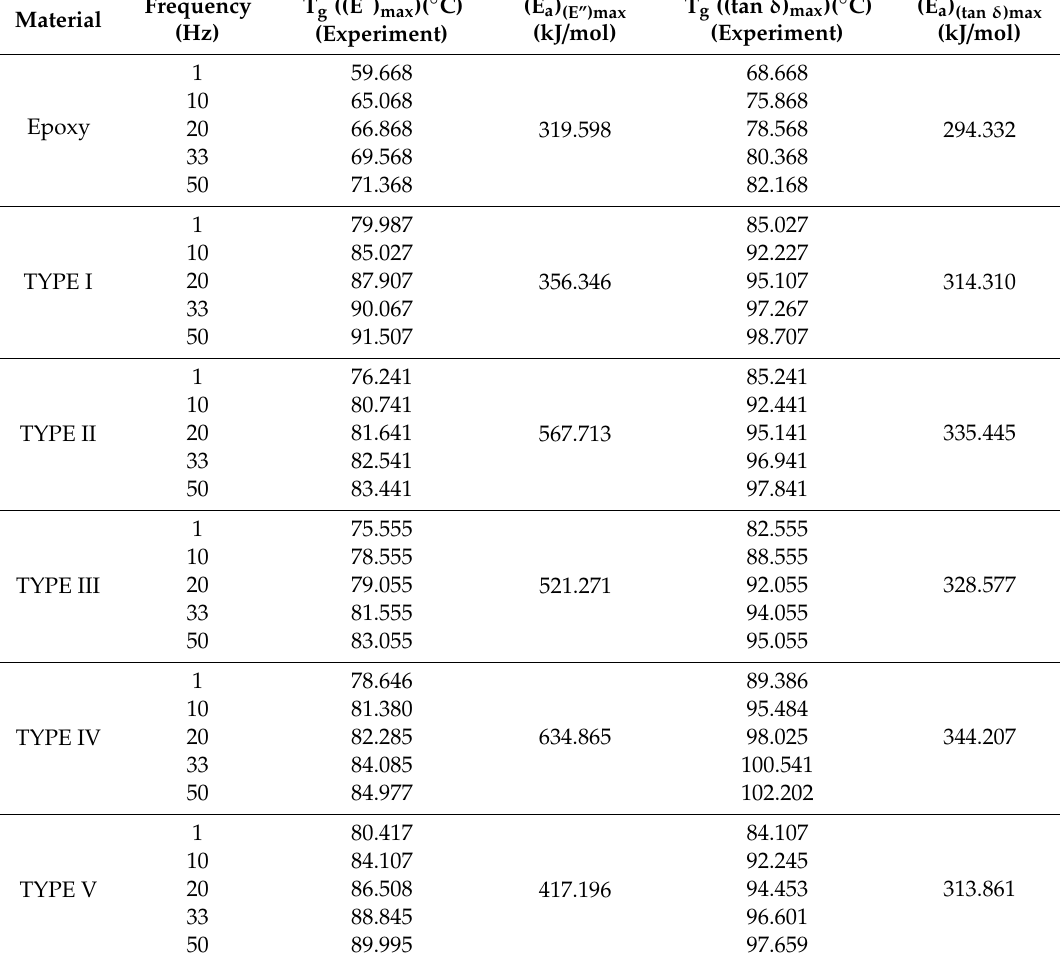
Table 3. Activation energy of epoxy and glass / epoxy composites.